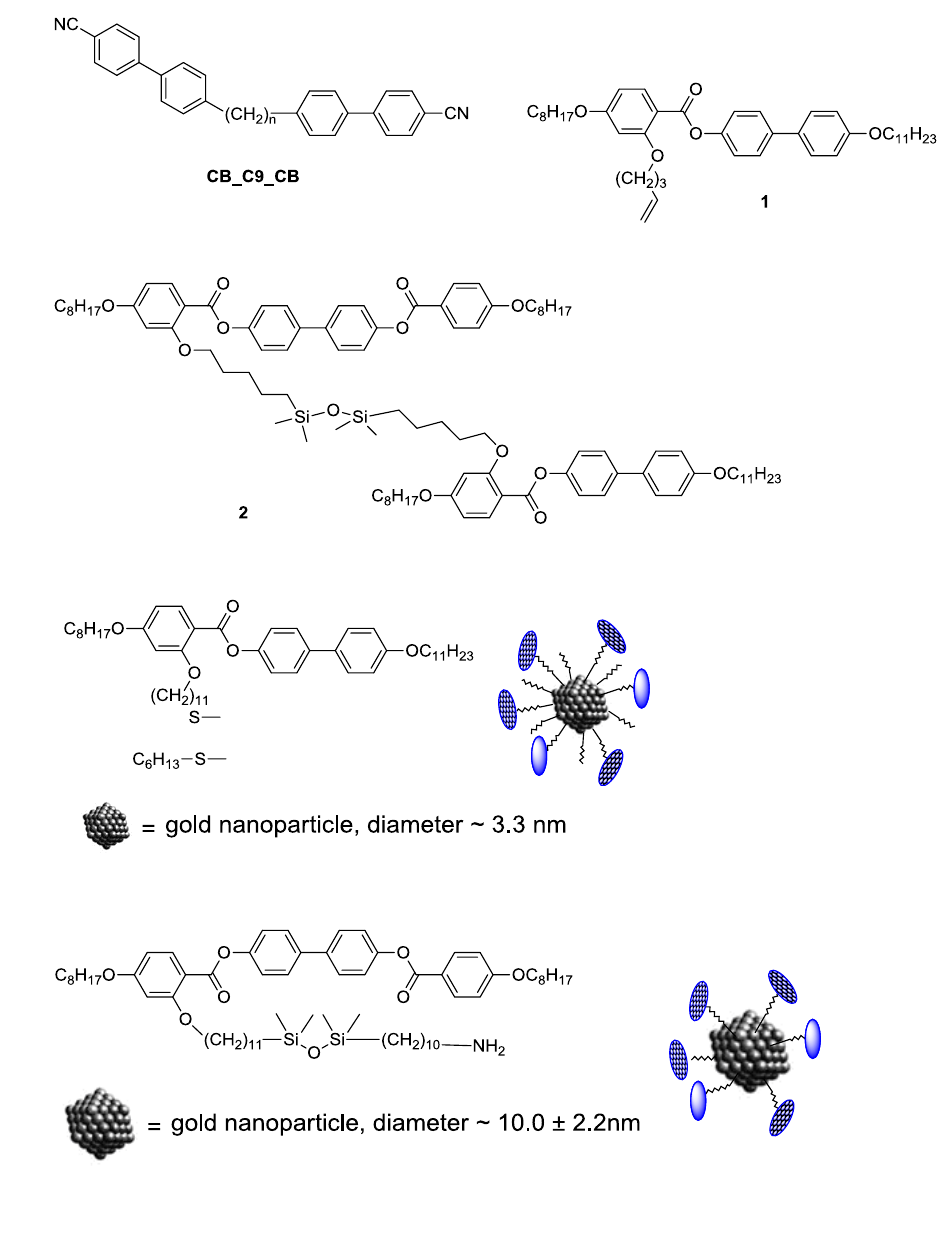
Figure 1. Chemical structures of the materials investigated. CB_C9_CB , cyanobiphenyl